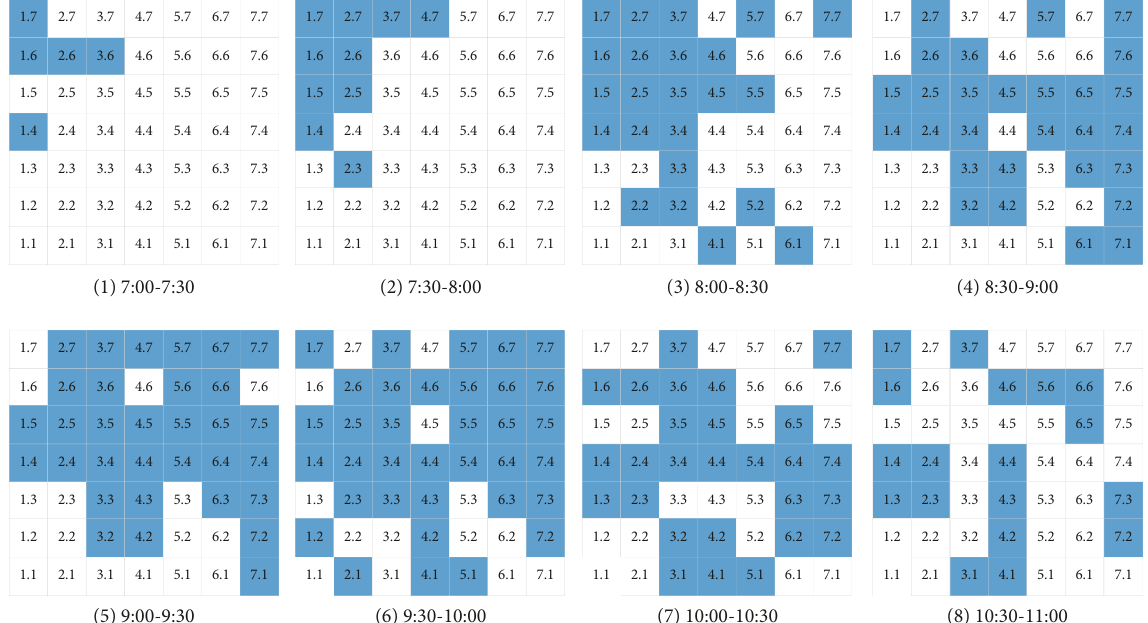
Figure 15: Evolution of congestion in morning rush hour.